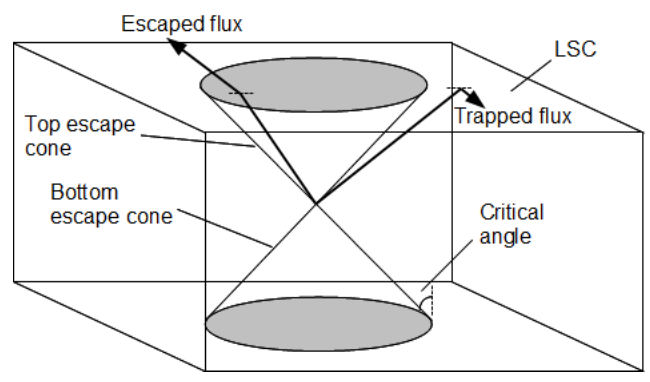
Figure 6. Escaped flux and trapped